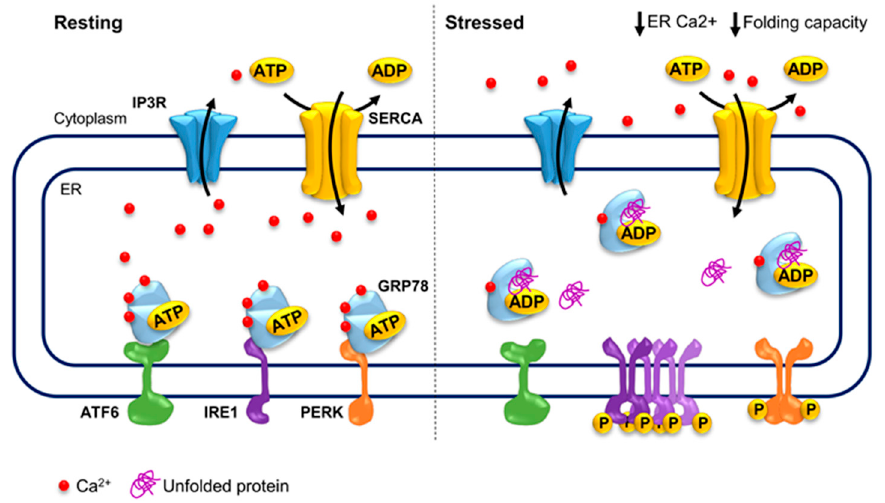
Figure 2. ER stress and its calcium dependency. During resting conditions, GRP78 inhibits the activation of ER stress mediators, ATF6, IRE1 and PERK, which in turn hinder the ATPase activity of GRP78. Furthermore, GRP78 buffers 25% of ER calcium and calcium levels highly modulate the protein folding activity of GRP78 and other protein chaperones. Upon stress, GRP78 dissociates from ER stress mediators, leading to their activation and triggering the ER stress response. GRP78: Heat Shock Protein Family A (Hsp70) Member 5; ER: endoplasmic reticulum; ATF6: Activating Transcription Factor 6; IRE1: inositol requiring enzyme 1; PERK: PKR-like ER kinase.